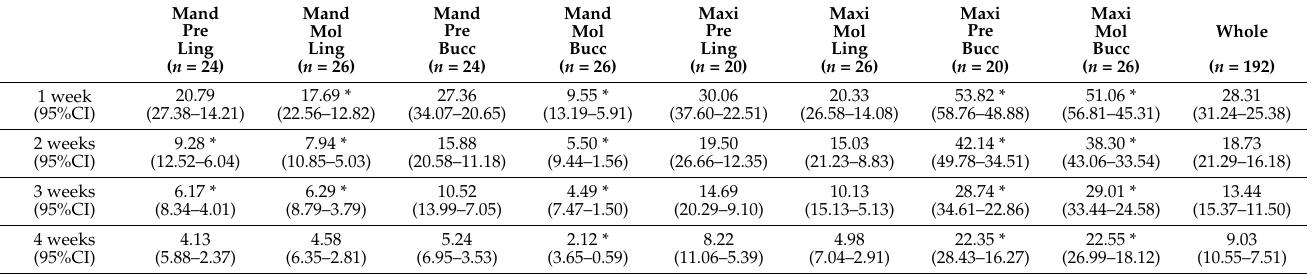
Table 4. The average Bio Coat Ca adhesion rate (%) of the area divided into eight sections.